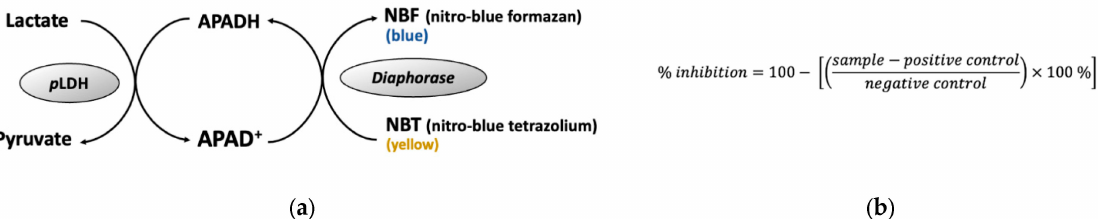
Figure 12. Principle of p LDH assay. ( a ) p LDH assay reaction, ( b ) formula for calculating the inhibitory activity of the proliferation of P. falciparum cell. Sample, A 650nm , of reaction mixture with the presence of sample; positive control, A 650nm , of reaction mixture with the presence of 1 µ M atovaquone; negative control, A 650nm , of reaction mixture with the presence of 0.4%